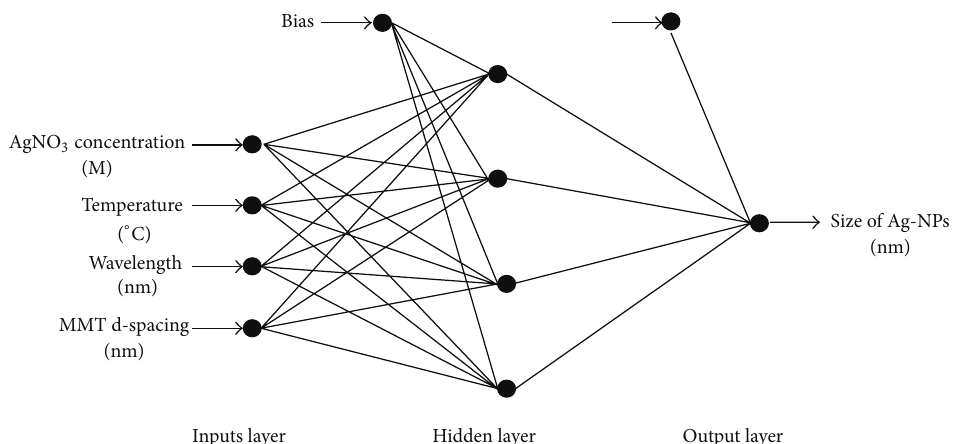
Figure 2: Schematic diagram of MLP neural